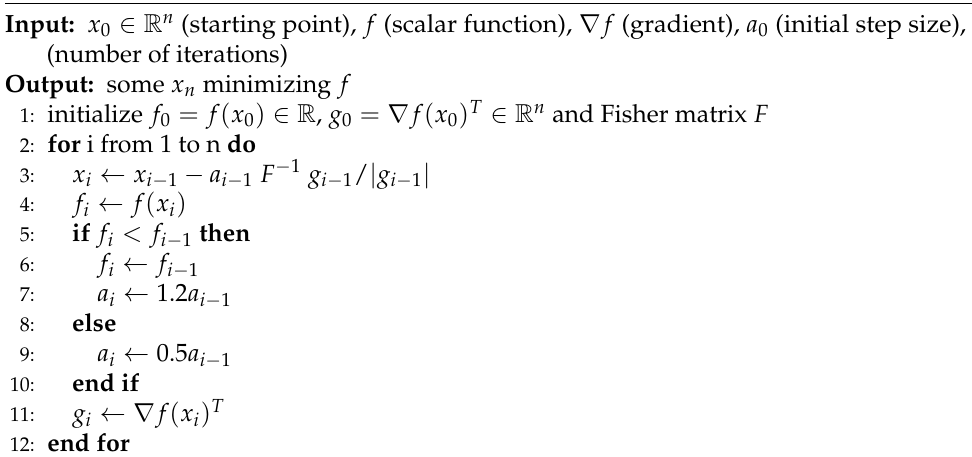
Algorithm 3 Natural Gradient Descent with Dirichlet and Generalized Dirichlet Distribu-